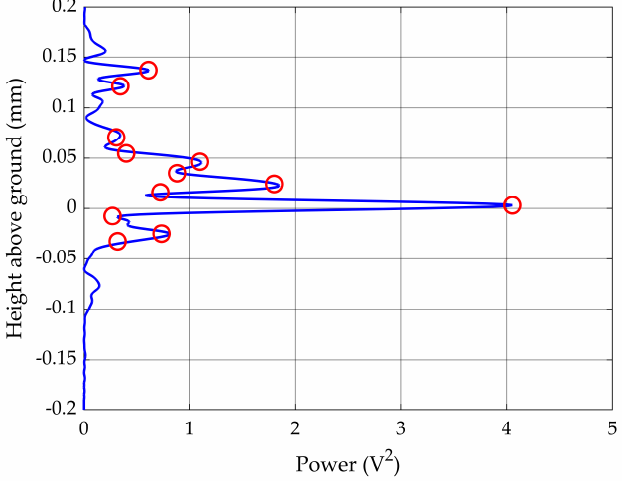
Figure 9. CLEAN detection of peaks from one profile of Transect 3, Pass 6, at 10 km h -1 .